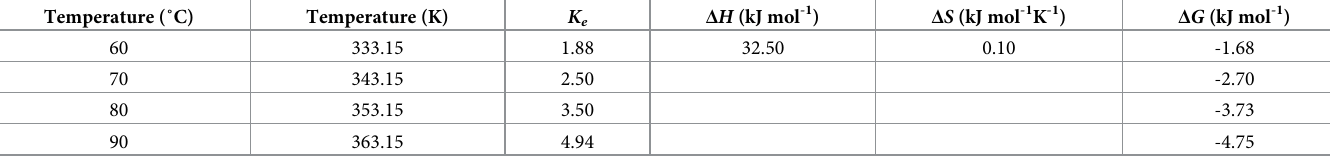
Table 6. Thermodynamic parameters ( Δ H , Δ S and Δ G ) for the extraction of EPA from N . oceanica at different temperatures. Temperature